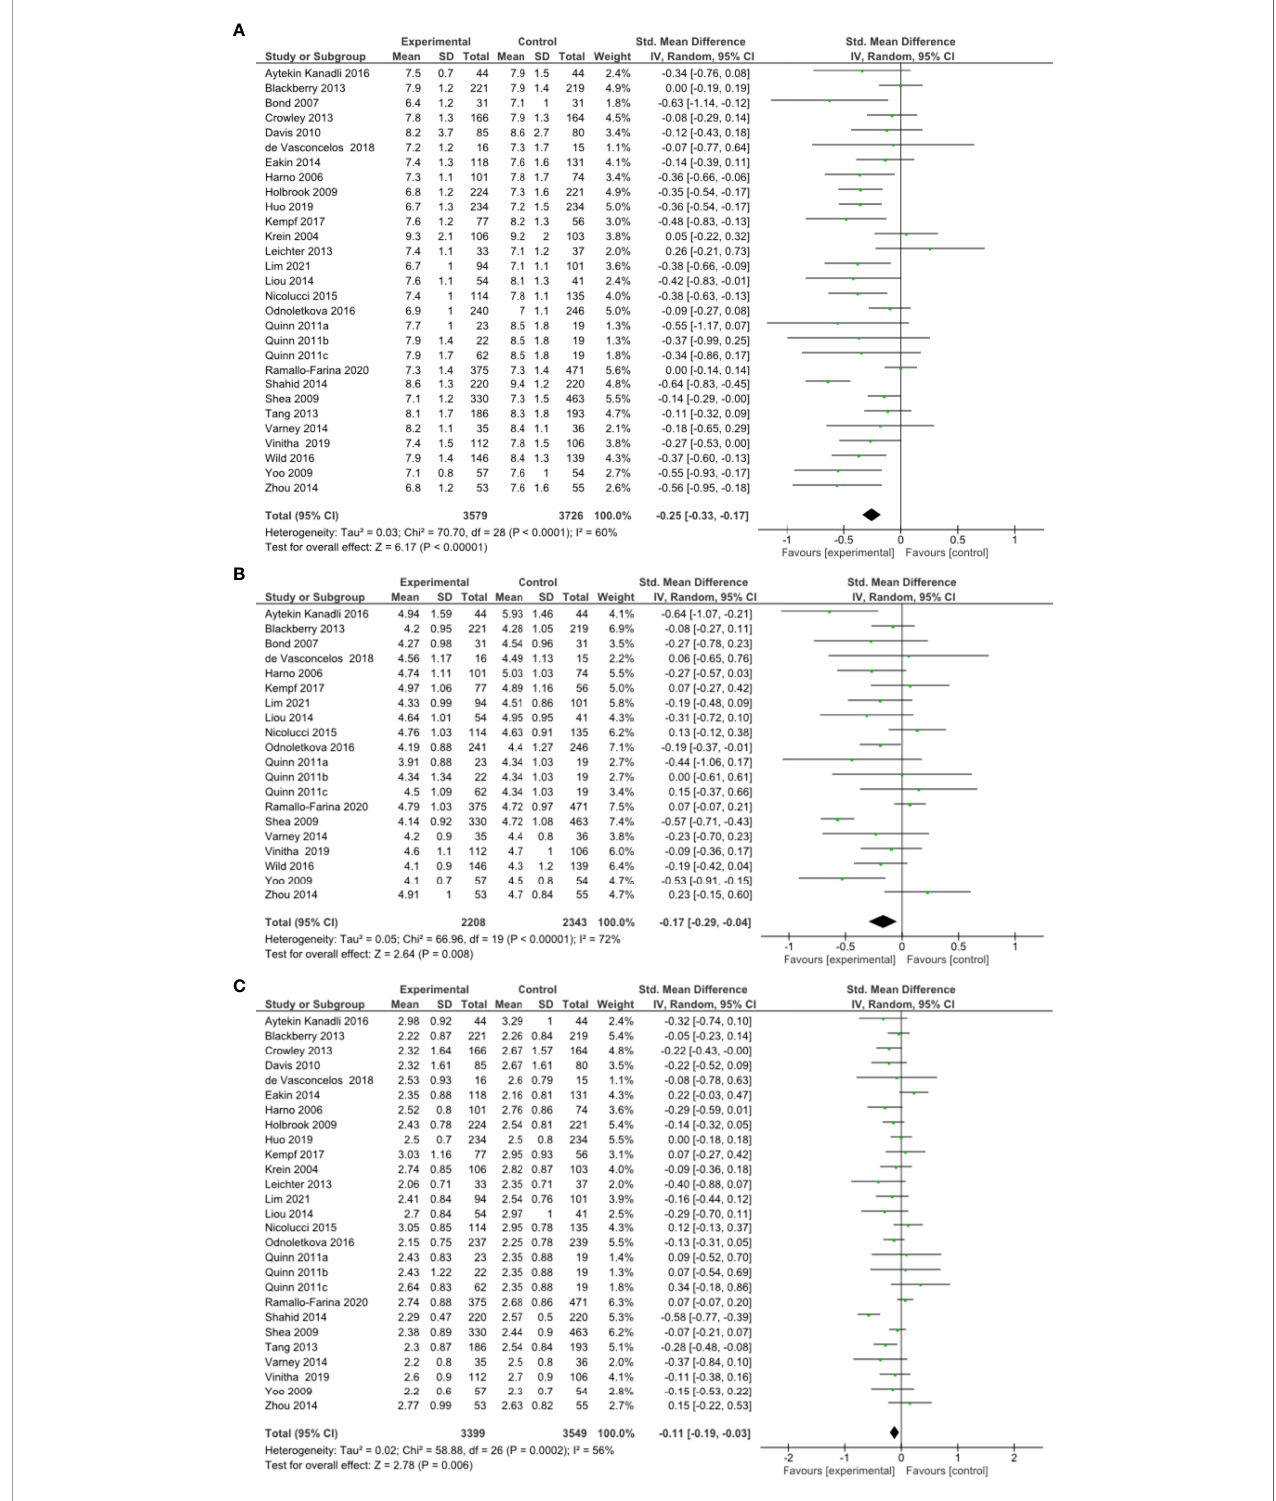
FIGURE 2 | (A) Forest plot showing the effect of remote risk factor management on HbA1c, (B) Forest plot showing the effect of remote management on total cholesterol, (C) Forest plot showing the effect of remote risk factor management on